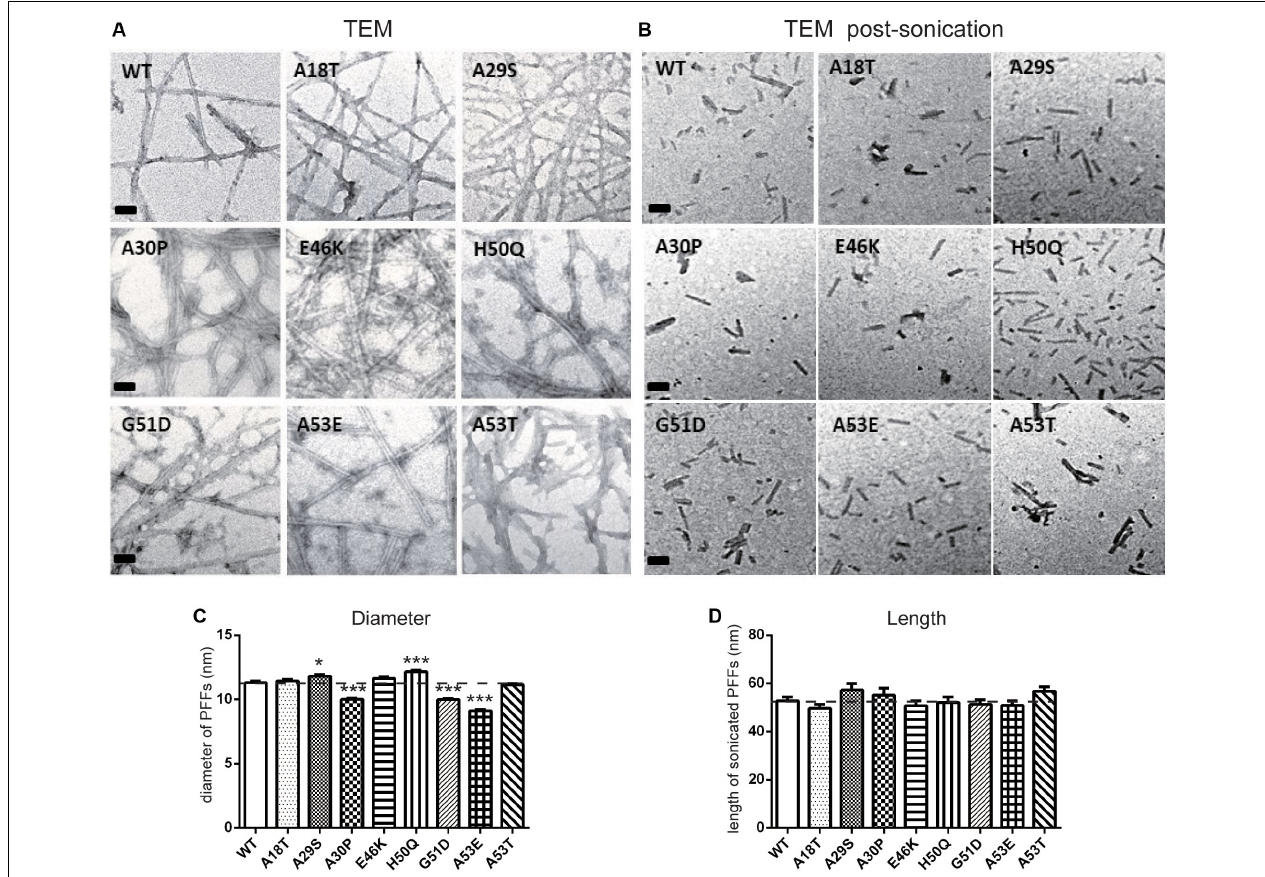
FIGURE 3 | Transmission electron microscopy analysis of PFFs. (A,B) TEM images of negatively stained PFFs before (A) and after sonication (B) (scale bars, 50 nm). (C,D) Diameter (C) and length analysis (D) of PFFs (mean ± SEM; * P < 0.05, *** P < 0.001 compared to WT, one-way ANOVA followed by Dunnett’s test compared to WT; n = 300 in 3 independent